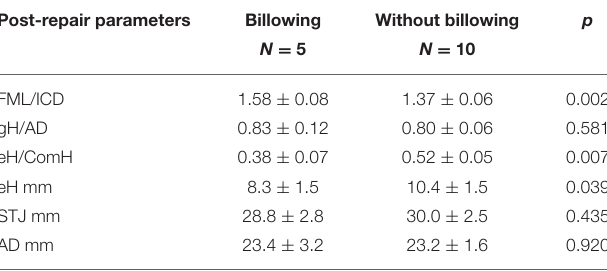
STJ, sino-tubular junction (area-derived diameter); AD, annulus diameter; FML, free marginlength;ICD,inter-commissuraldistance;gH,geometricheight;eH,effectiveheight; ComH, commissure height.